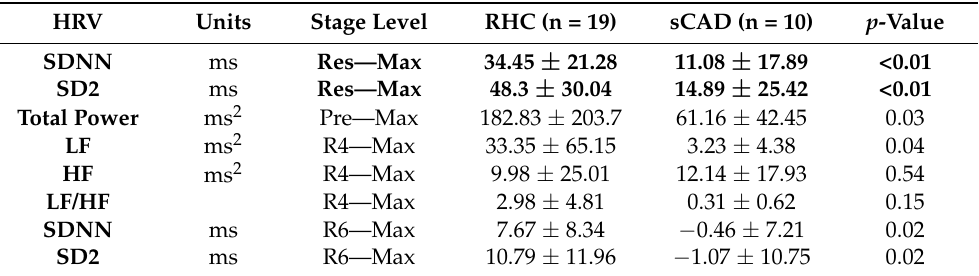
Table 2. A comparison of HRV indices between RHC and sCAD groups in individual EST stages with respect to Max stage. Only particular stages are listed in which the HRV indices between the two groups are significantly different. For the purpose of comparison, LF, HF, and LF/HF are also listed, which showed no statistical difference between the two groups. The SDNN and SD2 in Res with respect to Max, in bold, exhibited the best performance ( p <